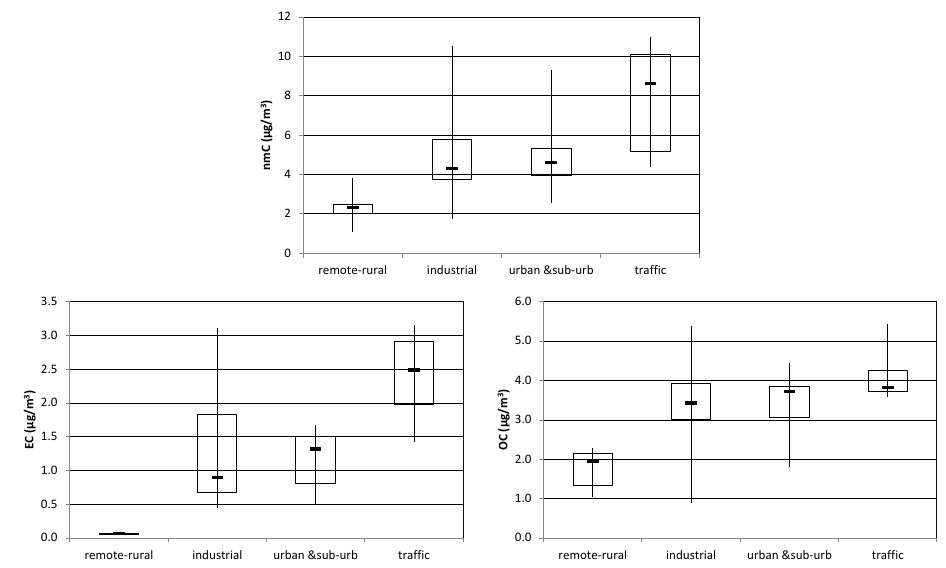
Figure 2. Mean nmC concentrations in PM2.5 (solid) and PM10 (blank), recorded in 78 study sites ordered from low to high and classified Fig. 2. MeannmC concentrations in PM 2 . 5 (solid) and PM 10 (blank), recorded in 78 study sites ordered from low to high and classified according the site type. according to the site type.